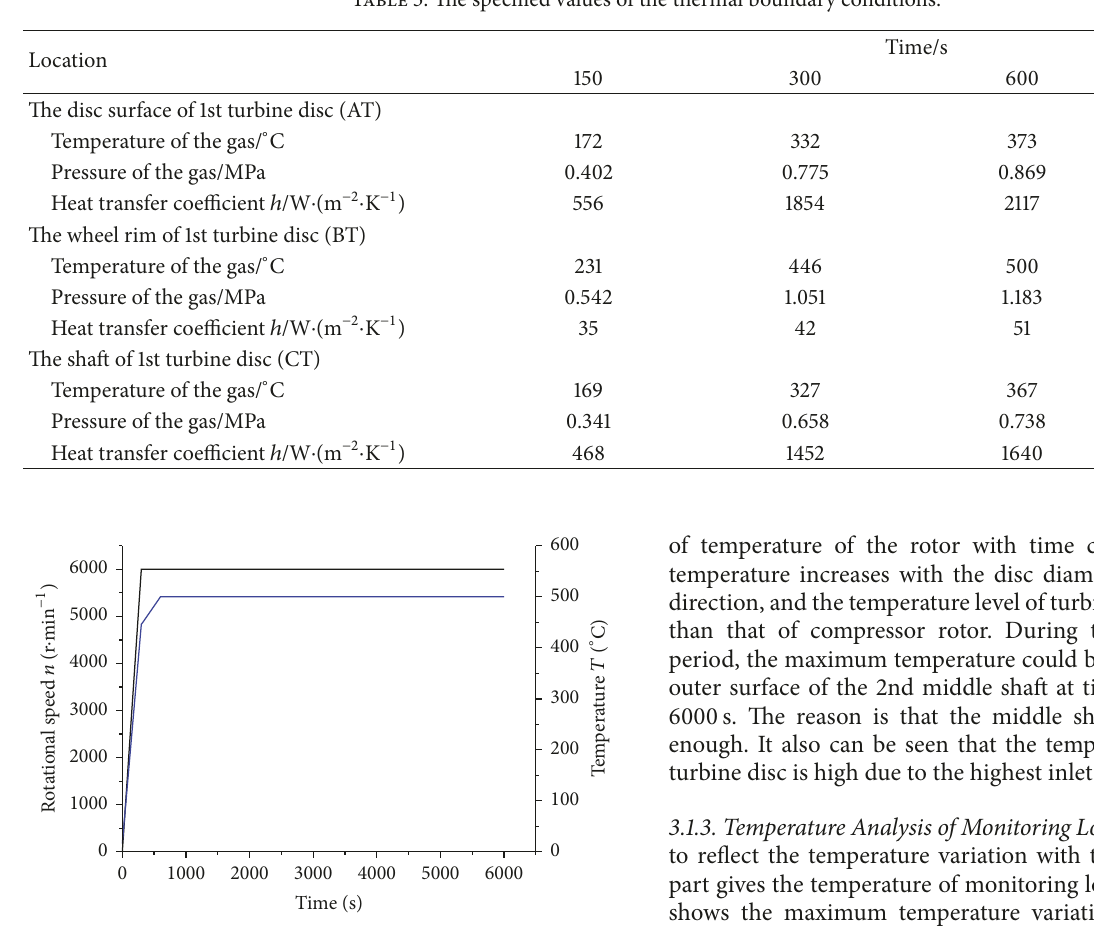
Table 3: The specified values of the thermal boundary conditions.